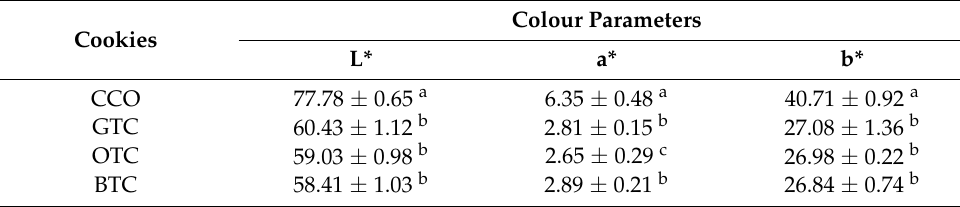
Table 5. Colours of non-gluten shortbread cookies with various spent tea leaves powder. Cookies